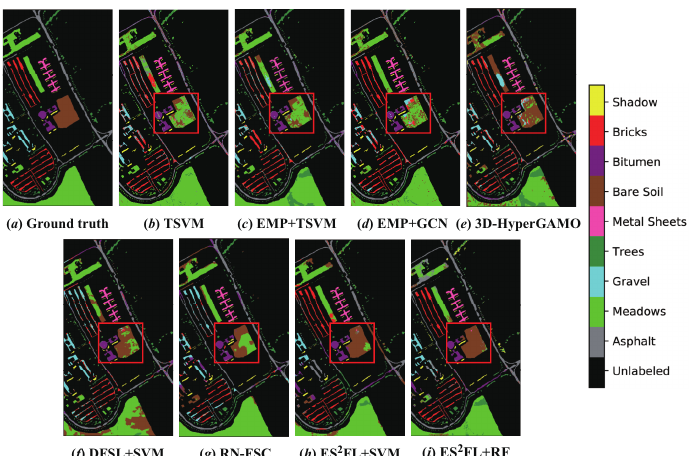
Figure 7. The classification maps resulting from different methods on the UP data set in the case of small samples.